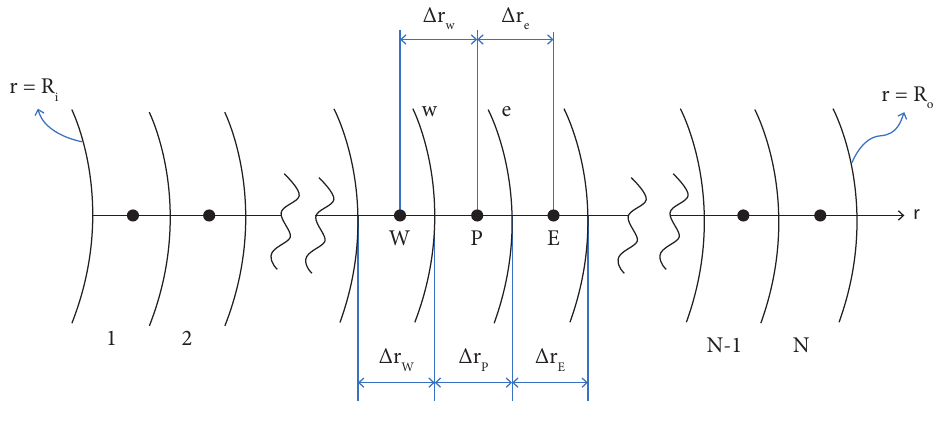
Figure 2. Uniform one-dimensional